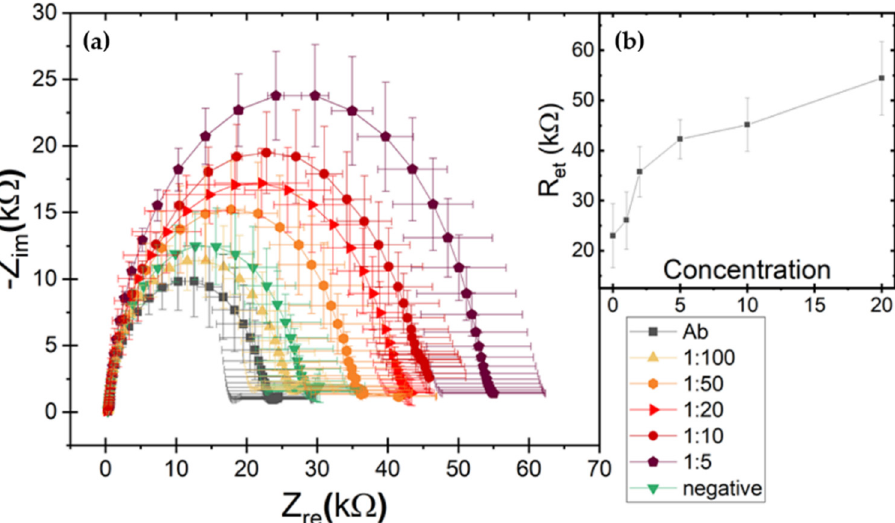
Figure 4. ( a ) Nyquist spectra in response to serial dilution of GFLVs virus source homogenate. Black curve is related to antibody functionalization. Negative sample response corresponds to green curve. Incubation with positive samples leads to higher impedance values, from 1:50 (orange curve) to 1:5 (purple curve) with an increased darkness in the curve color ( b ) Biosensor calibration curves for GFLV in terms of R et (mean ± SD) vs. concentration expressed as 100 divided dilution factor. R et was evaluated by means of fits with a simplified Randles equivalent circuit model.